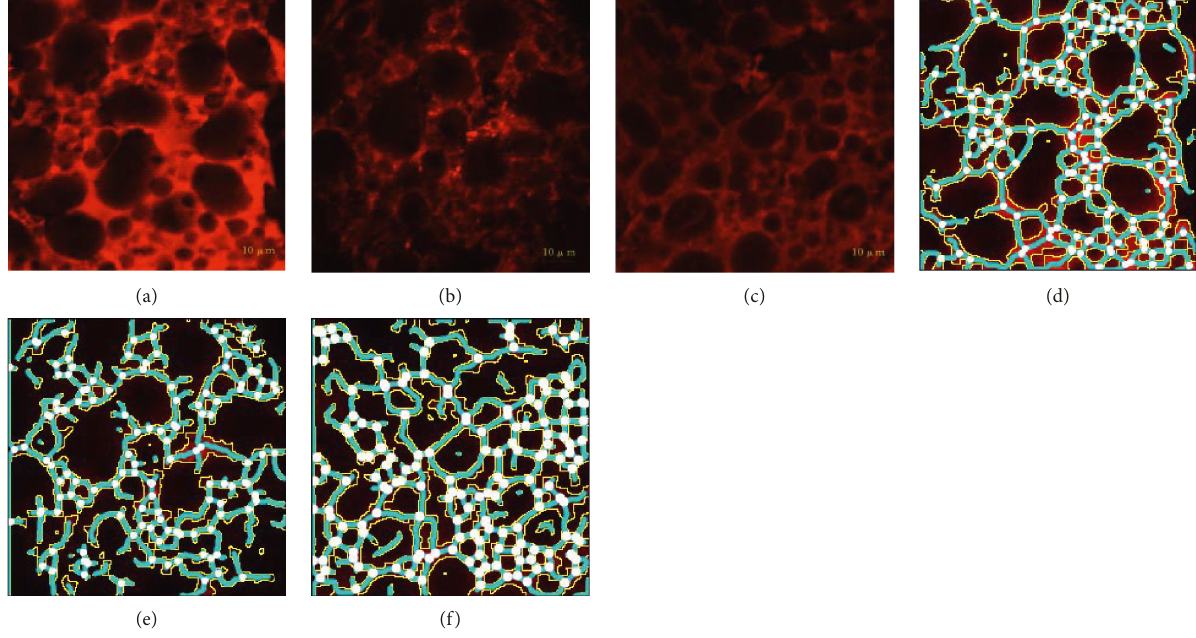
Figure 4: Protein network analysis of dough samples prepared from GY2018, YM13, and SKN1. Subscript (a-c) is the original CLSM captured, with a scale bar of 10 μ · m; subscript (d–f) is processed by AngioTool, with junctions in white, gluten skeleton in green, and protein outline shown in yellow. Subscript (a) D represents the dough structure of GY2018; subscript (b) E represents the dough structure ofYM13; and subscript (c) F represents the dough structure of SKN1. Table 3: Quantitative analysis of the gluten network in GY2018, YM13, and SKN1 determined by AngioTool software. Samples